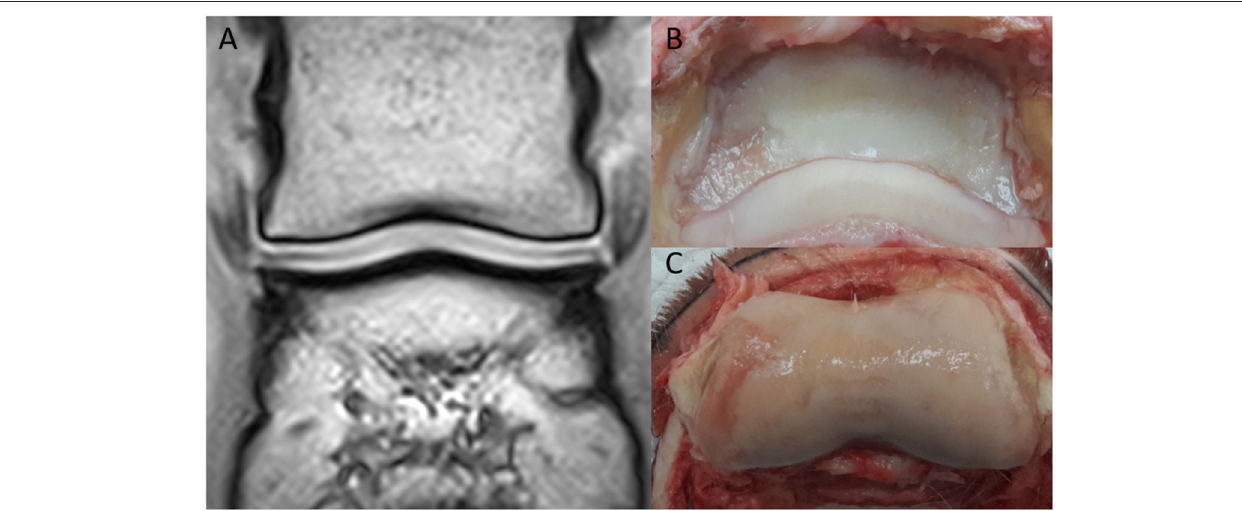
FIGURE 2 | Clinical case from the pilot study, horse two. Medial is to the left. (A) Dorsal T1-weighted sequences in plain low-field MR, no significant abnormalities were identified. In the medial and lateral aspect of the distal phalanx (B) , there is cartilage erosion (more pronounced medially). There is a full-thickness cartilage defect medially in the middle phalanx (C) , with yellow/gray discoloration of the articular cartilage.